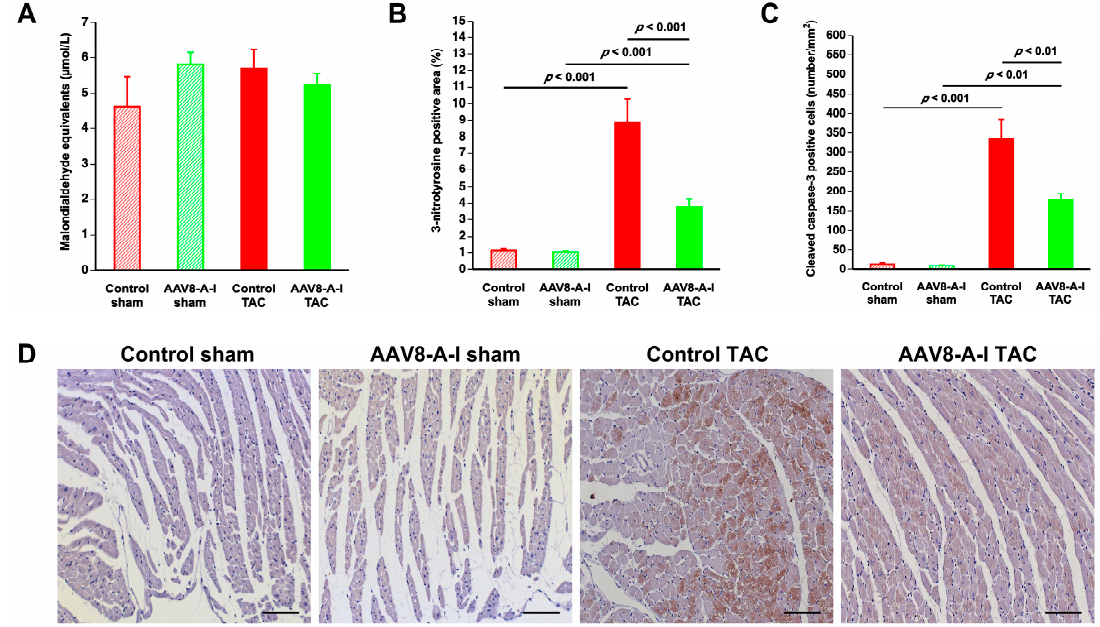
Figure 4. Quantification of oxidative stress and cardiomyocyte apoptosis in sham mice and in transverse aortic constriction (TAC) mice at day 56 after operation. Sham mice and TAC mice are indicated by open bars and closed bars, respectively. Plasma thiobarbituric acid-reactive substances (TBARS) expressed as plasma malondialdehyde equivalents, the percentage of 3-nitrotyrosine-positive myocardial area, and cleaved caspase-3-positive cells in the myocardium are shown in panels ( A – C ), respectively. Panel ( D ) illustrates representative photomicrographs showing myocardial sections stained for 3-nitrotyrosine. All data represent means ± SEM ( n = 10). Scale bar represents 50 µm.